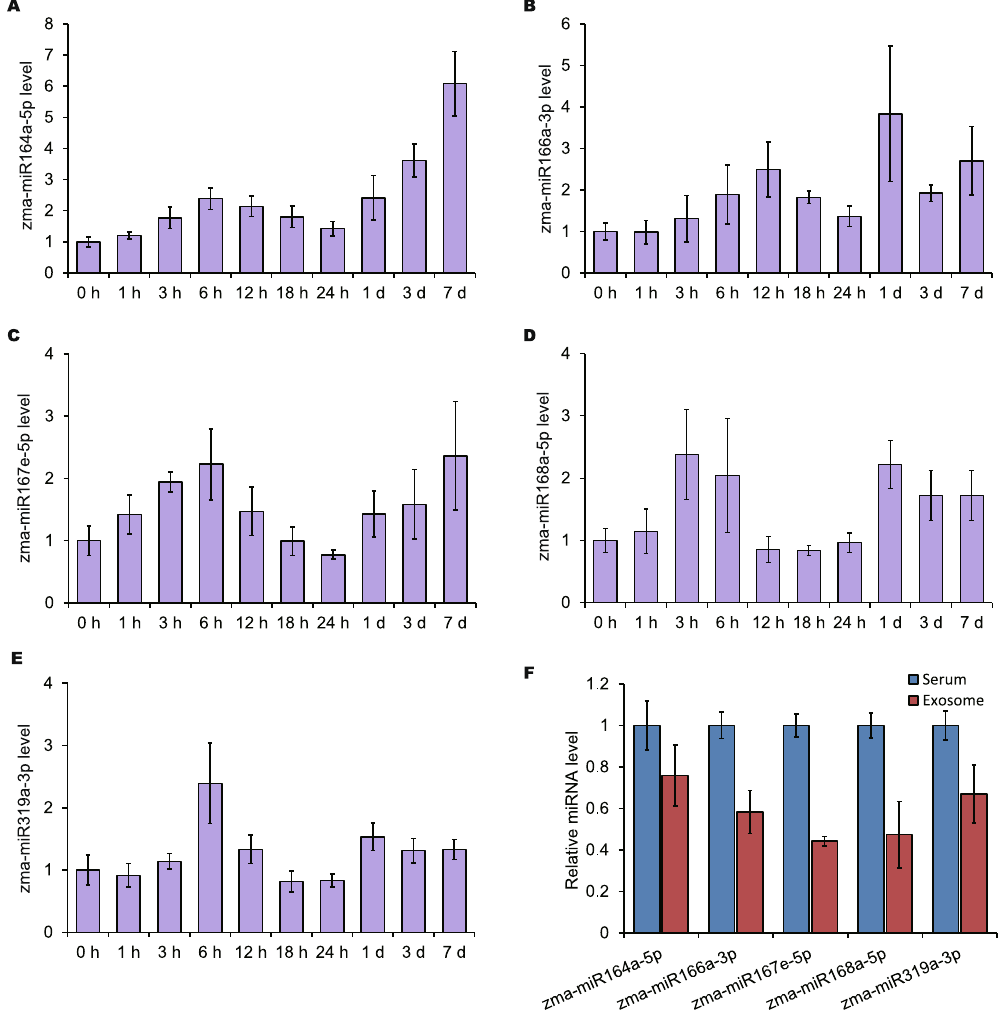
Figure 4. Dietetically absorbed maize miRNAs may be packaged into exosomes and present in the circulation. ( A–E ) The levels of zma-miR164a-5p ( A ), zma-miR166a-3p ( B ), zma-miR167e-5p ( C ), zma-miR168a-5p ( D ) and zma-miR319a-3p ( E ) in porcine serum following one feeding with 1 kg of fresh maize ( n = 6); after 24 h, the pigs were fed a fresh maize diet for 7 days. The miRNA levels were evaluated by qRT-PCR, and porcine serum was collected after overnight fasting as a control (0 h). ( F ) The levels of plant miRNAs detected by qRT-PCR in exosomes isolated from porcine serum by ultracentrifugation ( n = 3). Data were normalized to the miRNA levels of serum containing